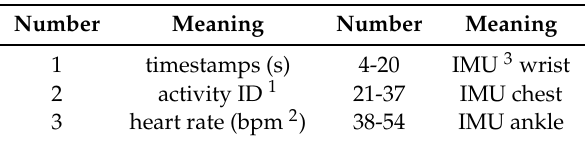
Table 2. The meaning of each column in